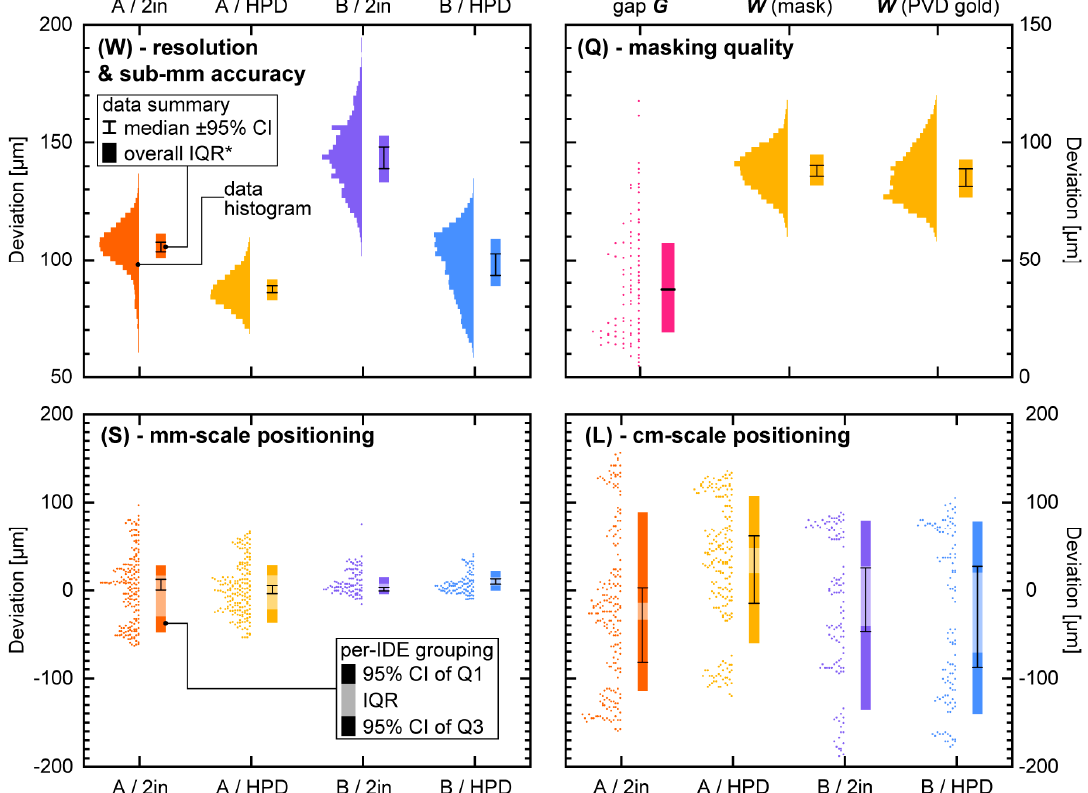
Figure 4. Deviation from nominal design targets (cf. Table 2) for a range of parameters, for ( W , S , Q ) as a function of Design and lens type. Colors (except magenta) correspond to those in Figure 2. The graphs show data distributions (histograms if n > 10,000) and corresponding summary parameters (median; interquartile range IQR; where applicable also 95% confidence intervals (CIs) and first / third quartiles (Q1 / Q3)). To derive CIs, data are grouped either on per-finger ( W , Q ; n (A) = 48; n (B) = 24) or per-IDE ( S , L ; n = 12 each) basis. ( W ) IDE finger width (at each pixel along finger length; n (A)~48 × 830; n (B)~24 × 1060), in Design A corresponding to the laser line width. IQRs* are for overall distribution (cf. main text). ( S ) IDE finger spacing (for each finger; n (A)~15.5 × 12; n (B)~8 × 12). ( L ) IDE finger length (for each finger; n (A)~17 × 12; n (B)~10 × 12). ( Q ) (left) Gap G between mask and substrate (at four points per IDE; N = 94; no grouping). (right) IDE finger width for a Design A mask written with HPD optics as well as corresponding PVD electrodes ( n ~24 × 760).